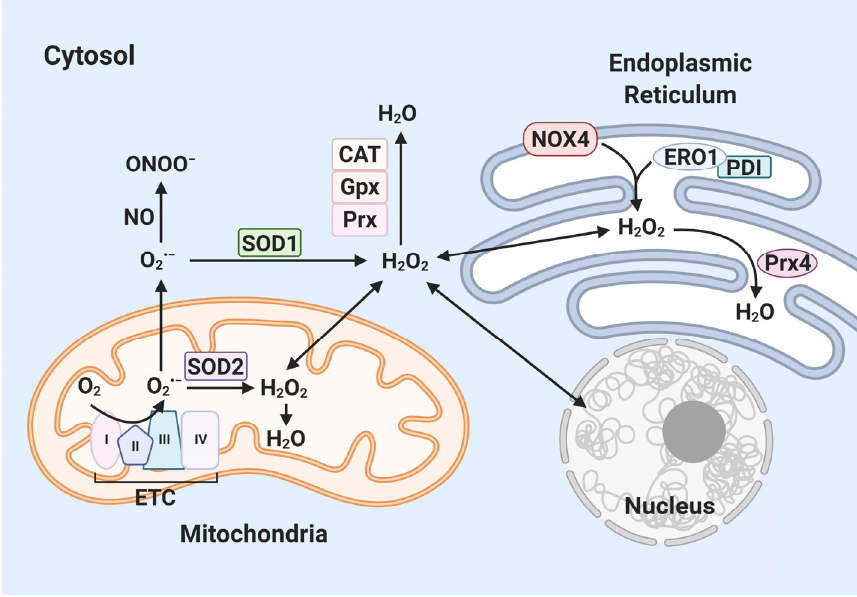
Figure 3. Generation of ROS in cytosol. Superoxide (O 2 • − , precursor of ROS) is generated in mitochondria and endoplasmic reticulum. O 2 • − produced in the mitochondrial ETC is dismutated into H 2 O 2 by superoxide dismutase (SOD) 1/2. H 2 O 2 is converted to water by catalase (CAT), glutathione peroxidases (Gpx) and peroxiredoxins (Prx). O 2 − reacts with NO to produce ONOO − . Inside the ER, ER oxidoreductin 1 (ERO1)/protein disulfide isomerase (PDI) and NADPH oxidase 4 (NOX4) produce H 2 O 2 . Prx4 reduces H 2 O 2 to water via a catalytic cysteine residue. (Created with BioRender.com accessed on 29 March 2021).